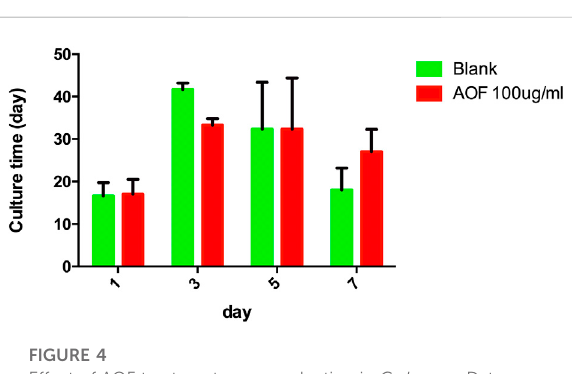
FIGURE 4 Effect of AOF treatment on reproduction in C.elegans . Data are the mean ± SD ( n = 3), p > 0.05 for all AOF groups vs Blank groups.